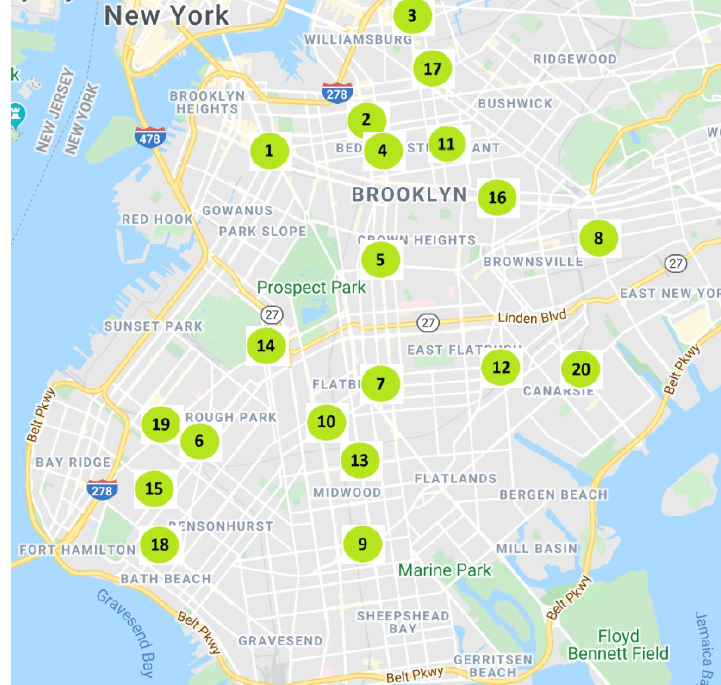
Figure 3. Possible locations for the mobile charging stations in Brooklyn, New